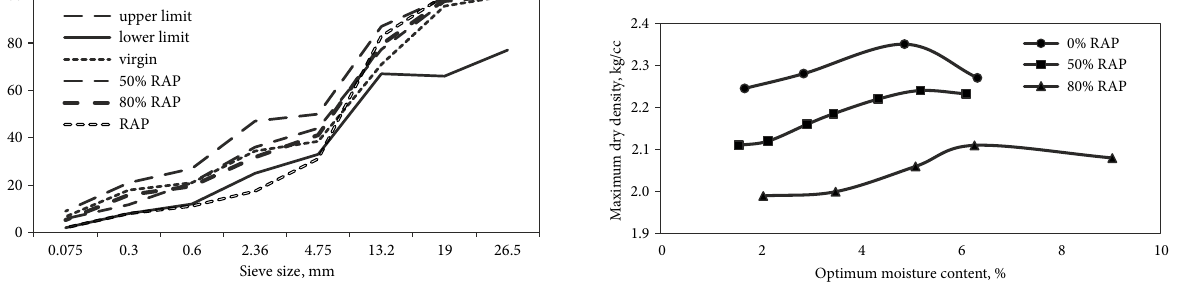
Figure 2. Aggregate gradation of foamed bituminous mixtures used in present study